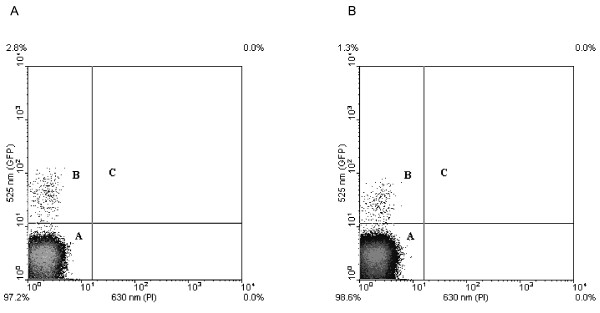
Antifoams do not affect cell viability. Viable cells without antifoam (A) and with 0.6% Antifoam A (as a representative example; B) are shown. Population A, which is not cellular, comprises events that are related to electronic and particulate noise. Population B comprises cells with enhanced green fluorescence due to the expression of GFP. Population C is where any dead cells (stained red with propidium iodide) would be observed.